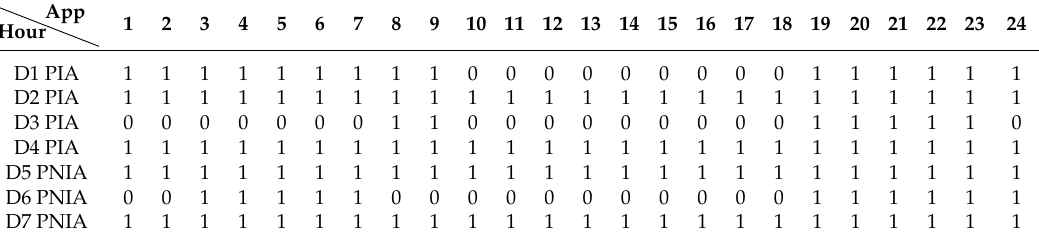
Table 3. Status matrix ( S ) of the programmable appliances.